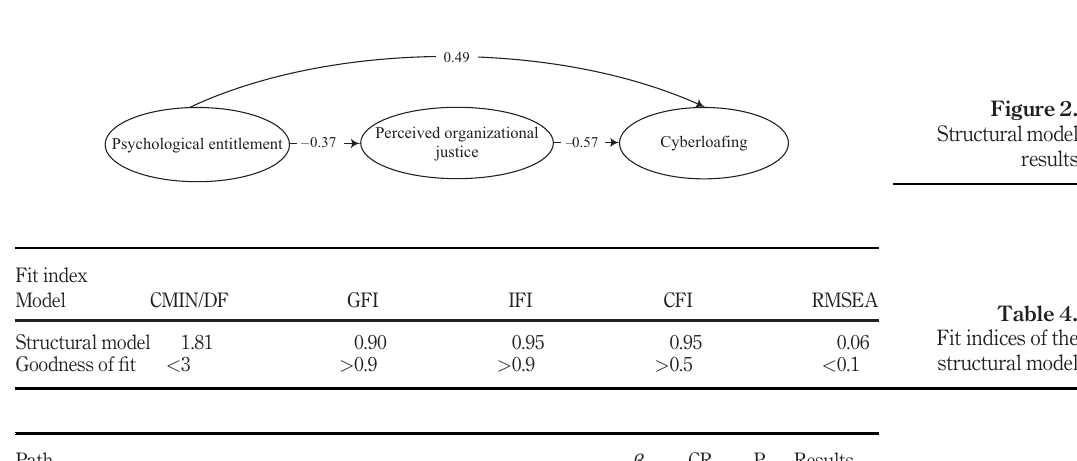
Table 5. The results of